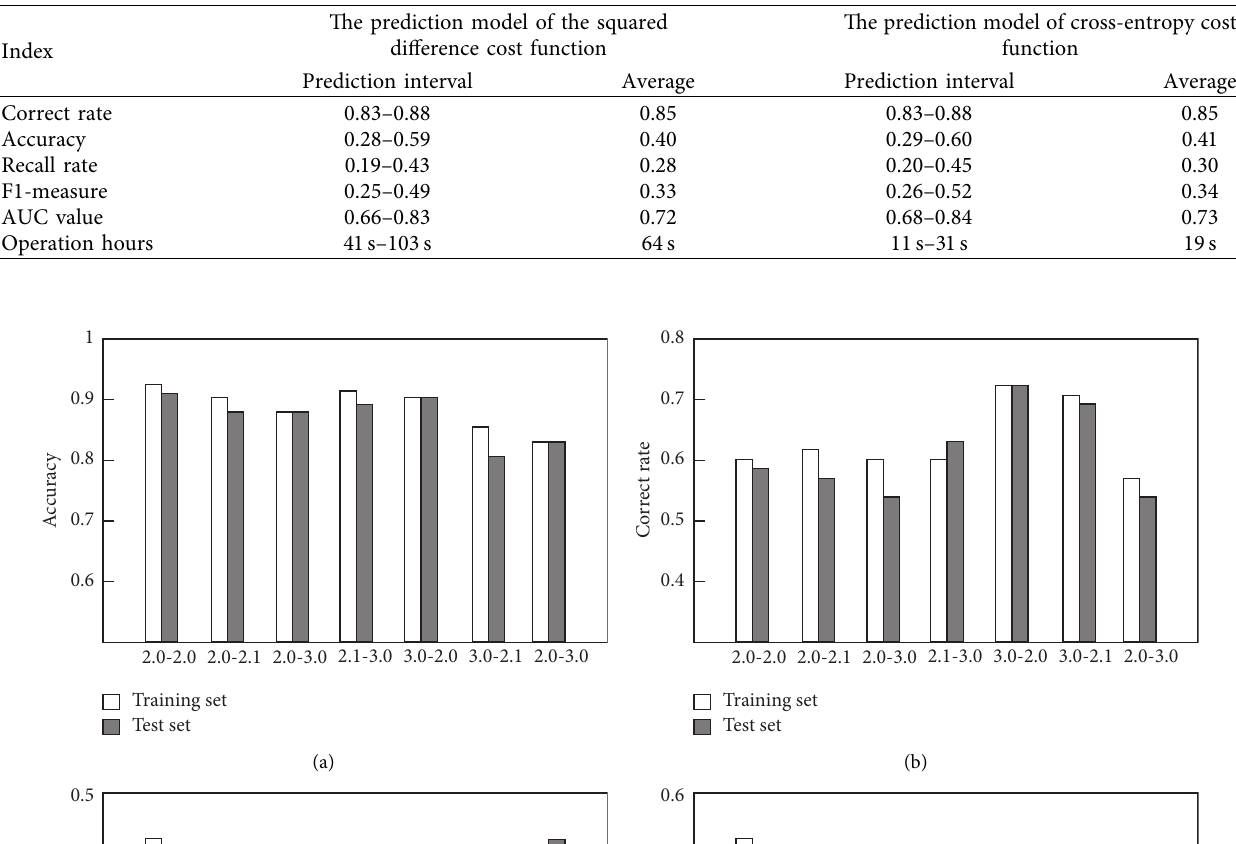
Table 4: Experimental data results.